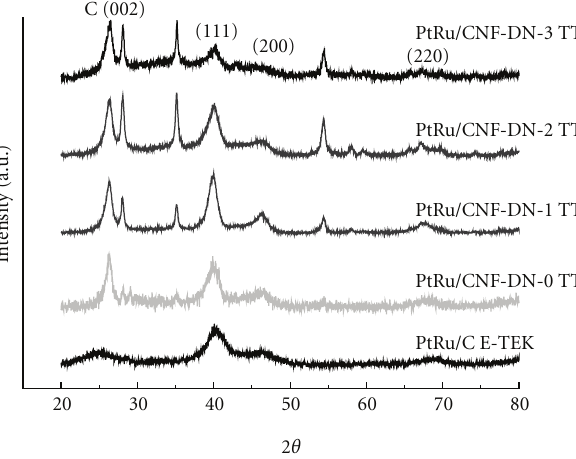
Figure 2: XRD di ff ractograms for the synthesized Pt-Ru catalysts submitted to heat treatment at 350 ◦